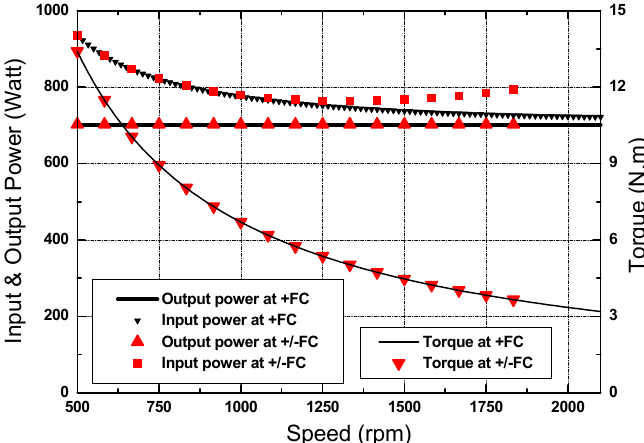
Figure 7. Stator current versus torque at reduced positive and reversed field current (FC).